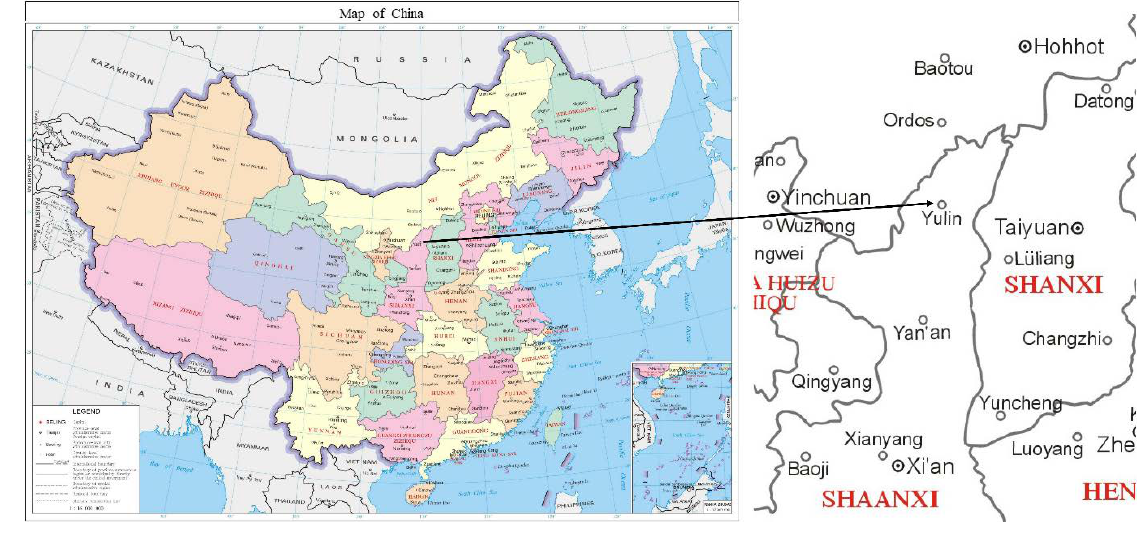
Figure 1. Schematic diagram of the location of the coal specimen collection place.